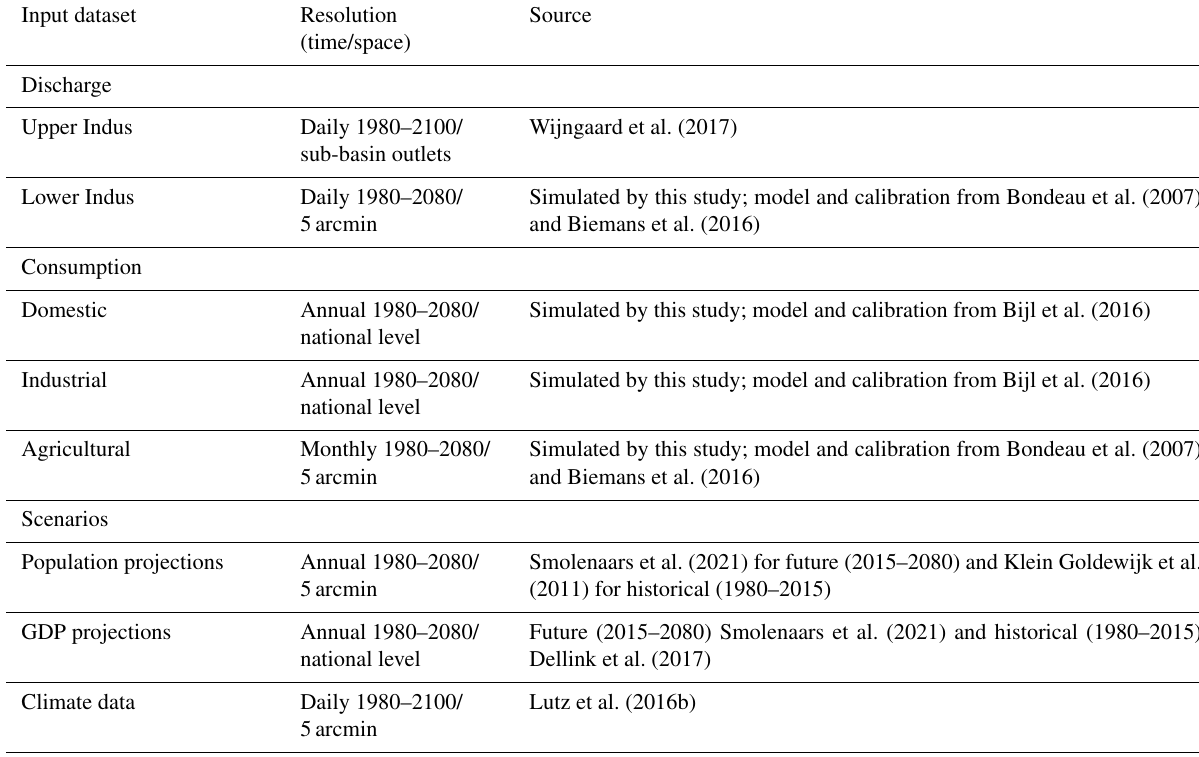
Table 1. Input datasets used for water accounting